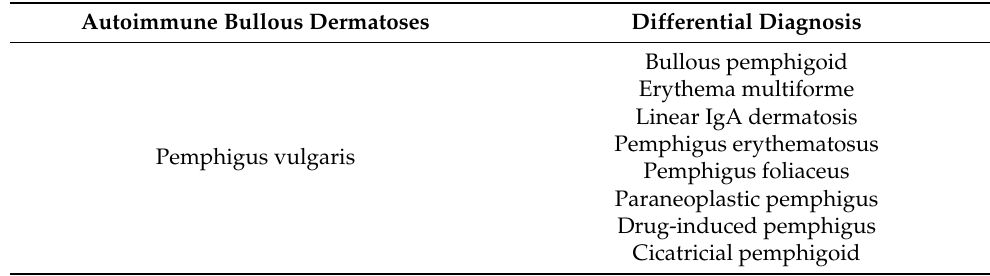
Table 3. Differential diagnosis of the main autoimmune bullous dermatoses with oral